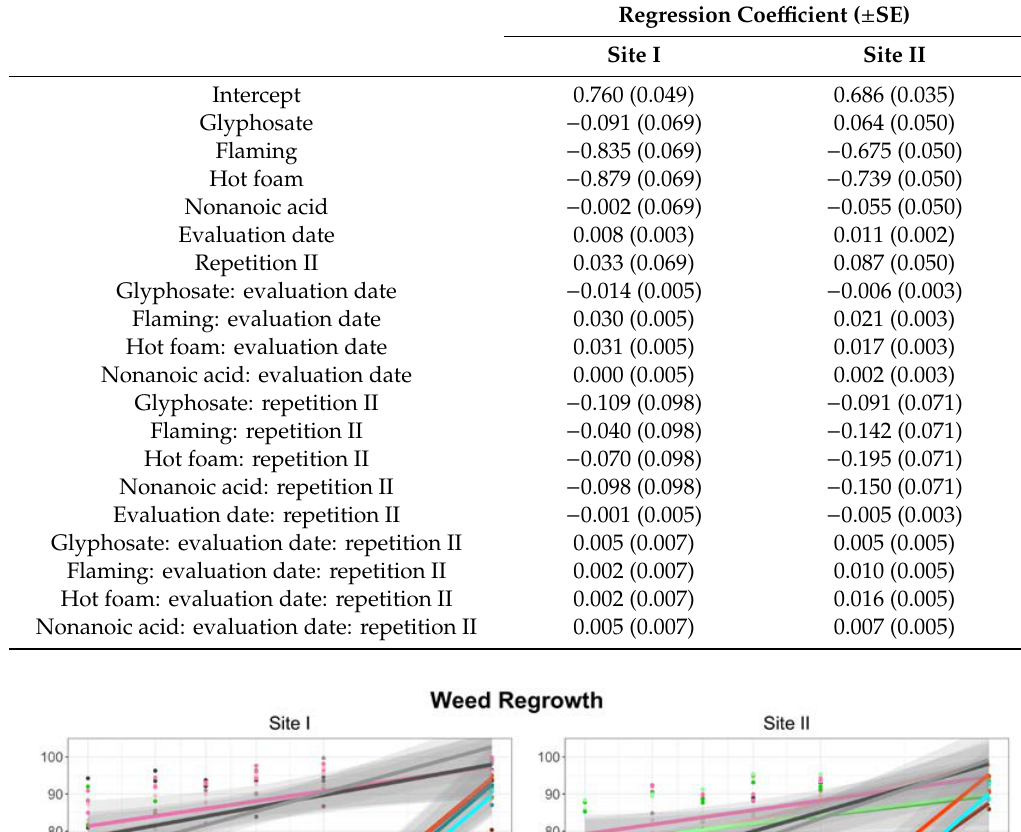
Table 5. Multiple linear regression coe ffi cients used to estimate the percentage weed cover per day of interest for each treatment, repetition, and site using the linear equations. Linear regressions lines are plotted in Figure 4.